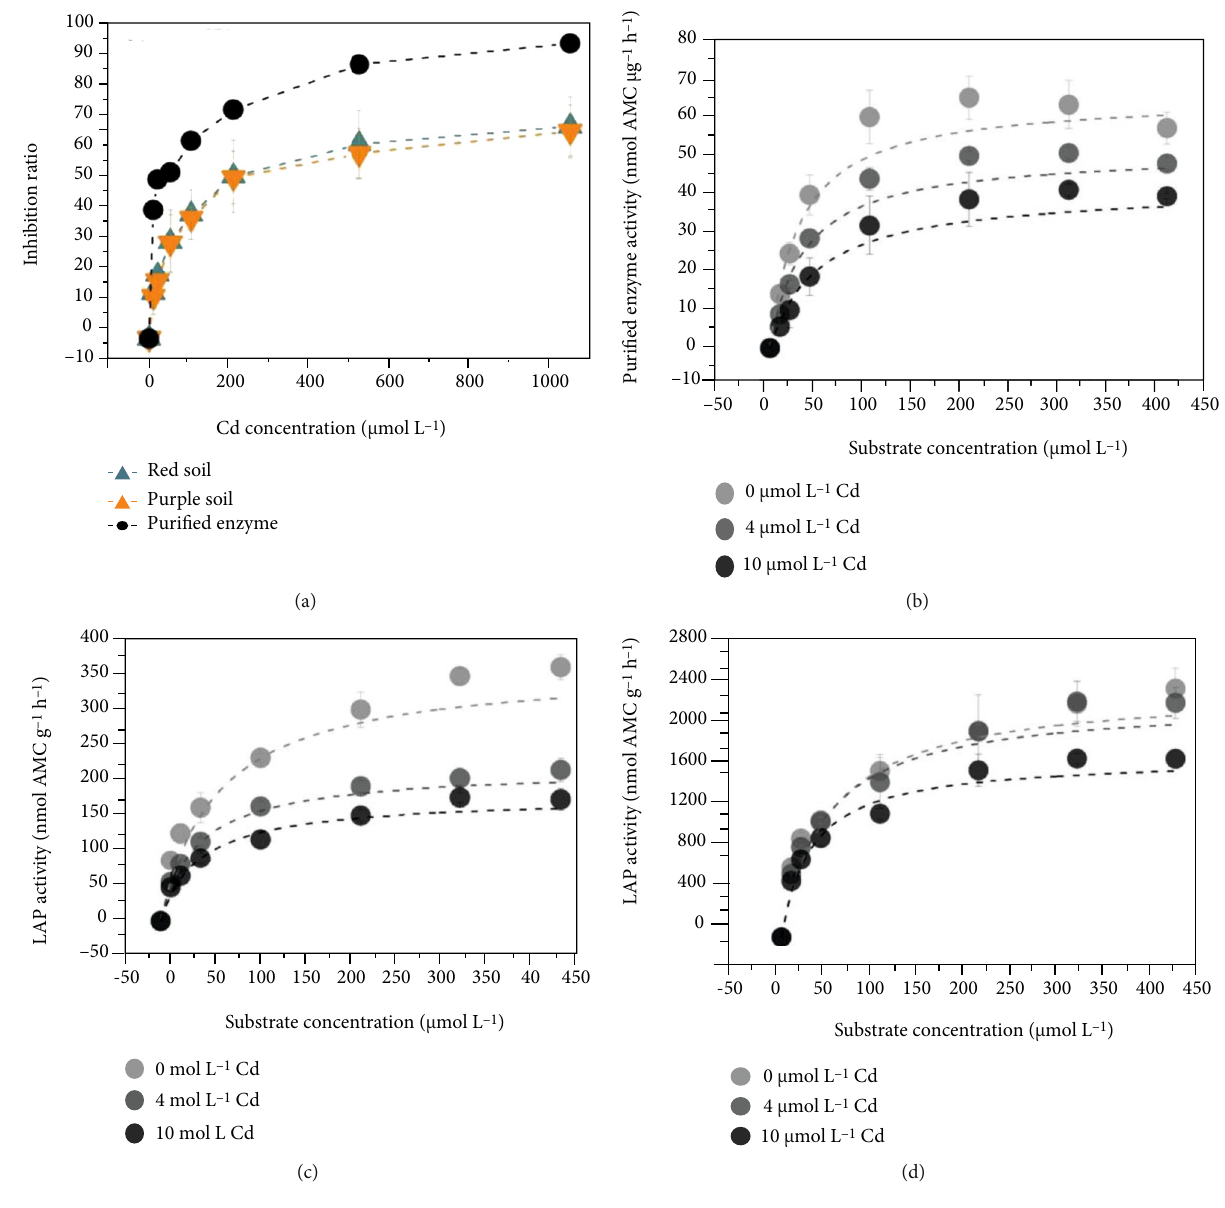
Figure 1: E ff ect of Cd on the inhibition rate and kinetic constants of LAP: (a) inhibition rate of soil LAP and puri fi ed LAP by di ff erent concentrations of Cd; (b) kinetic curve of puri fi ed enzyme a ff ected by Cd; (c) kinetic curve of LAP in red soil a ff ected by Cd; (d) kinetic curve of LAP in purple soil a ff ected by